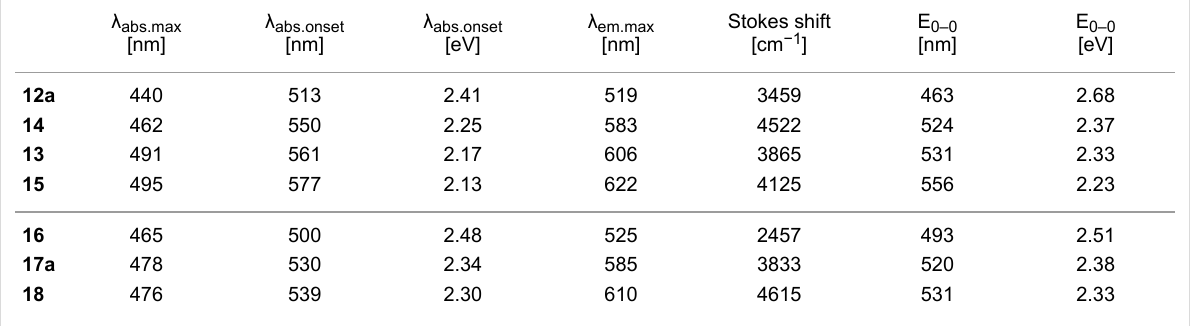
Table 1: Spectral data of the synthesized oligomers. Absorption and emission spectra were measured in CH 2 Cl 2 solutions. The zero–zero transition E 0–0 values were estimated from the intersection of the absorption and emission spectra.